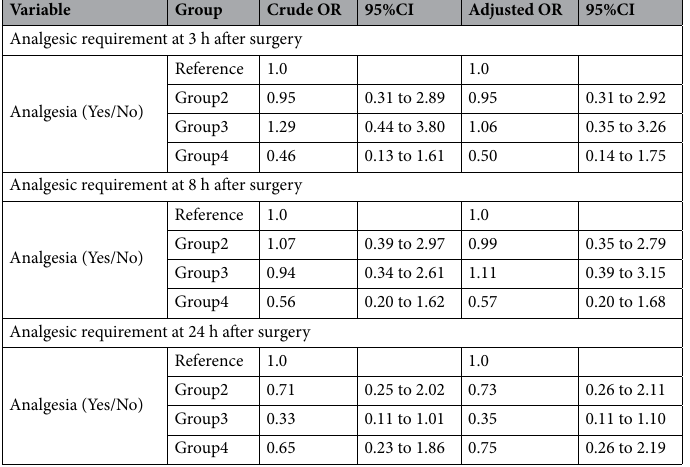
Table 5. Crude and adjusted odds ratios for analgesic treatment using logistic mixed effects models*. *The univariate and multivariate models were fitted using the surgeon’s identity as a random effect. The type of surgery (major vs. minor) and the Morphine Milligram Equivalents (MME) given during recovery were used as fixed effects in the multivariate